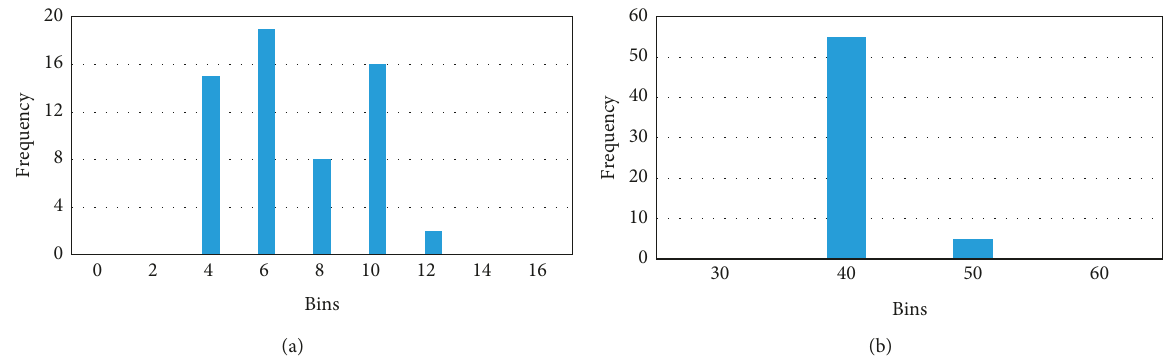
Figure 8: Variation of wind speed and temperature. (a) For wind speed and (b) for